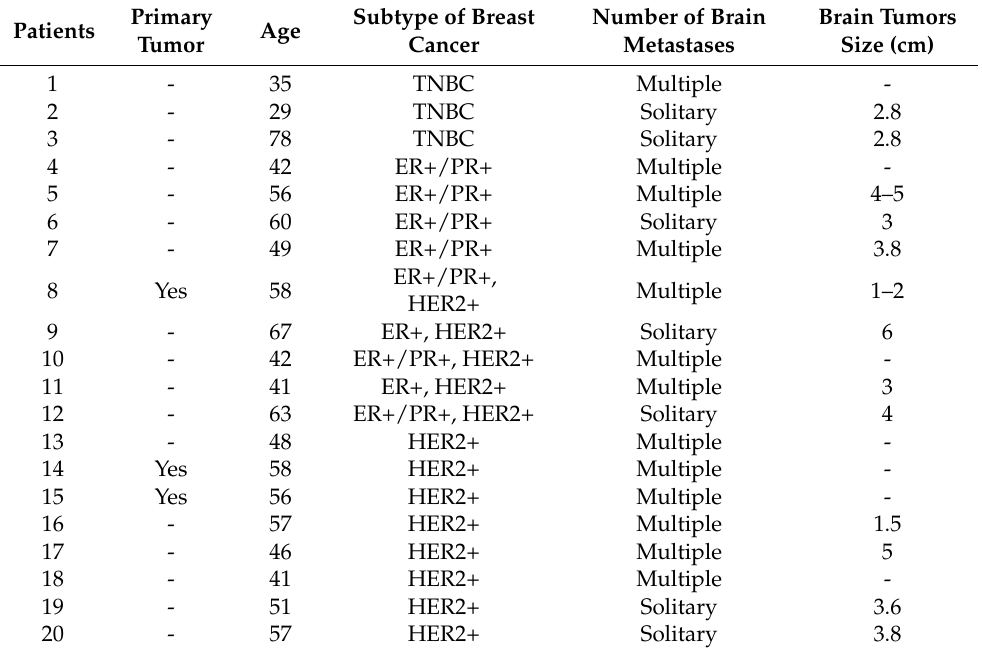
Table 1. Patients